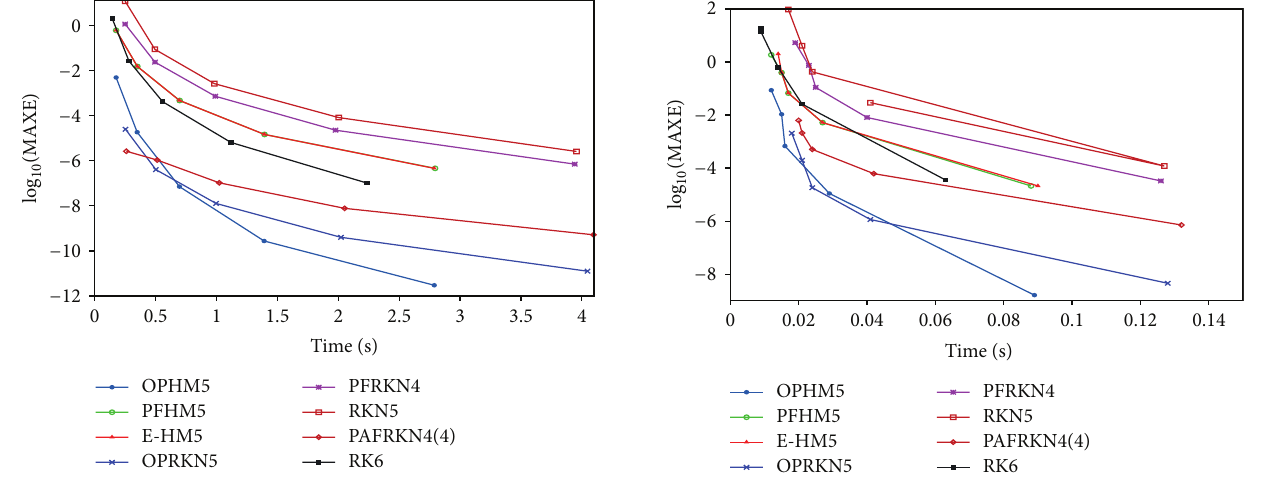
Figure 3: The efficiency curves of the optimized and phase-fitted = order five methods and their comparisons for Problem 4 with 𝑡 end 10 4 and ℎ = 1 − 0.125𝑖 , 𝑖 = 1, ...,5 .